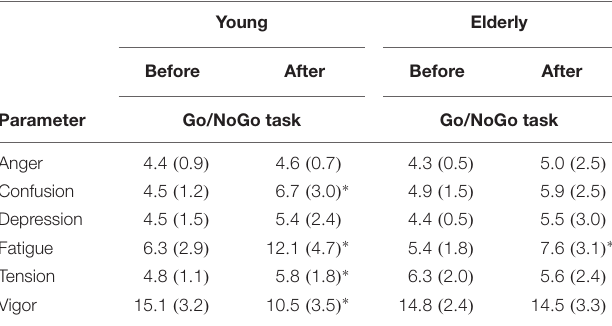
FIGURE 3 | Reaction time (RT) during 2 h “Go/NoGo” task. ∗ p < 0.05 compared with the first series; #p < 0.05 compared with the young men.